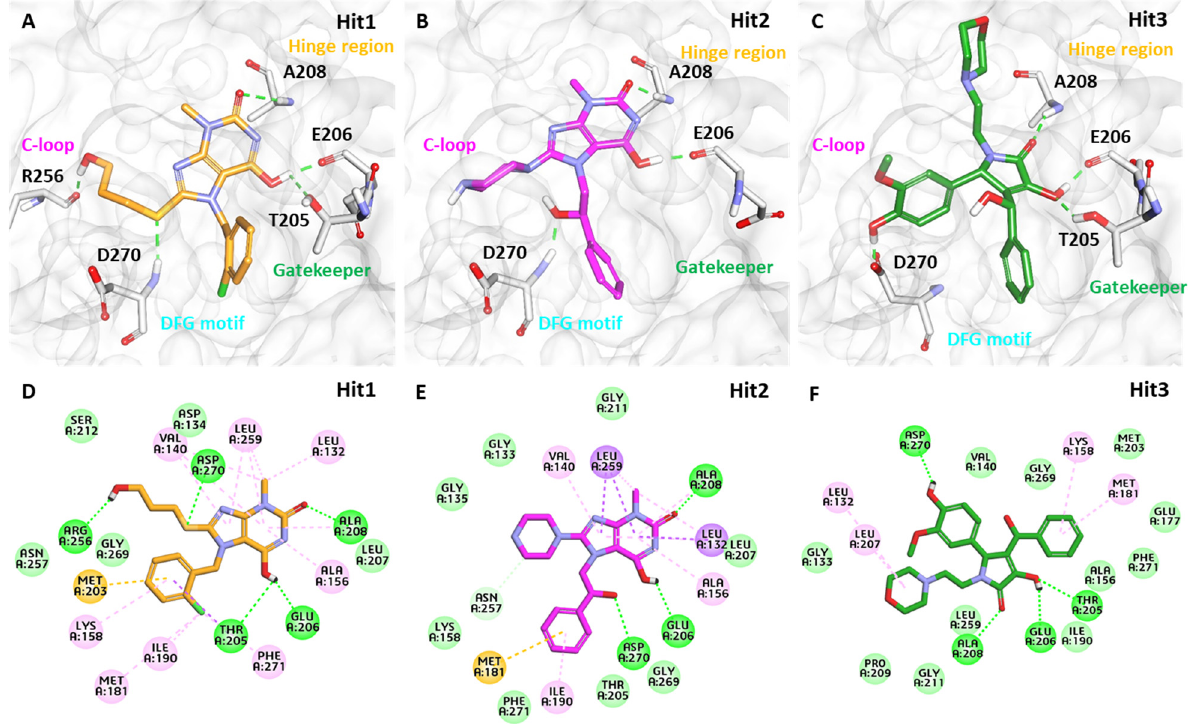
Figure 7. The 3D representation of the molecular interaction of ( A ) Hit1, ( B ) Hit2, and ( C ) Hit3. The hydrogen bonds are shown with green dashed lines. A lower panel ( D – F ) displaying detailed molecular interactions in 2D of Hit1, Hit2, and Hit3, respectively. Table 4. The detailed inter - molecular interactions between Hit compounds and ACK1.